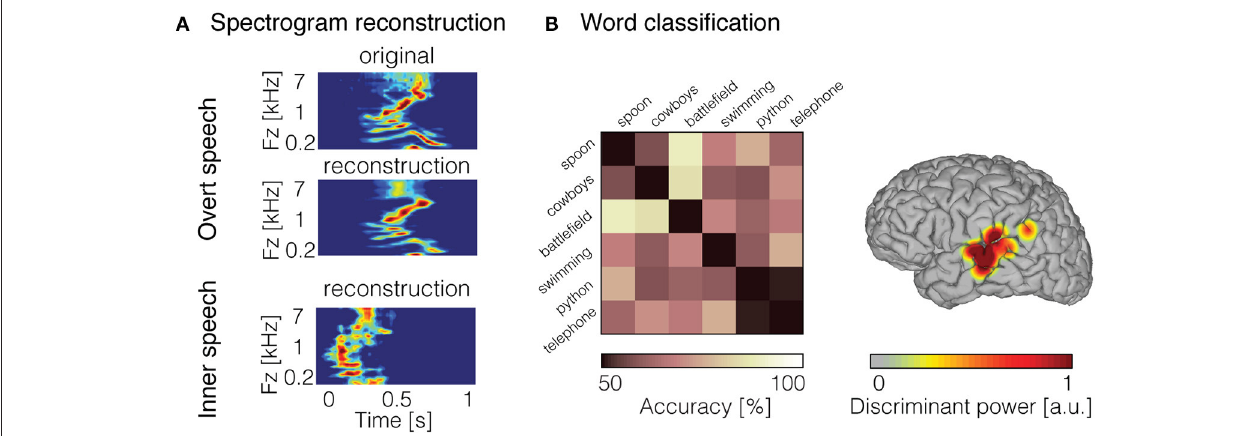
FIGURE 3 | Decoded inner speech representation. (A) Examples of overt speech and inner speech spectrogram reconstruction using linear regression models. Original spectrogram of the recorded overt speech sound is displayed (top panel). Reconstruction of the spectrogram for the overt speech condition (middle panel) and inner speech condition (bottom panel). (B) Examples of word pair classification during inner speech (left panel). Chance level was 50% (diagonal elements), whereas pairwise classification accuracy (off-diagonal elements) reached 88% and was significantly above chancel level across the 15 pairs of word (mean = 69%). Discriminant information displayed on the surface reconstruction of the participant’s brain (right panel) for the classification accuracy shown in the left panel. Figures adapted from Martin et al. (2014, 2016) with permissions.